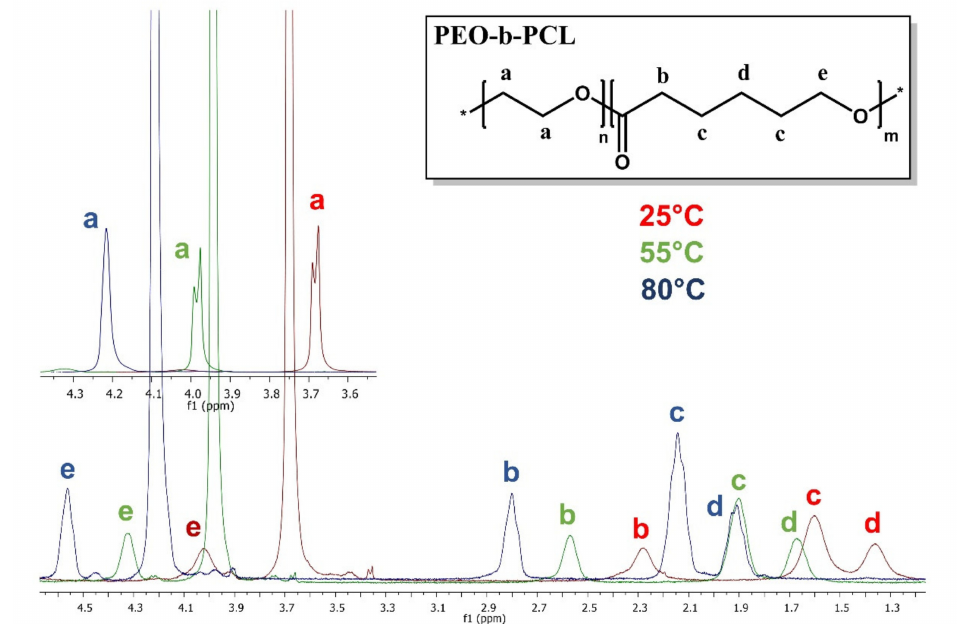
Figure 12. Comparison of 1 H-NMR spectra of -PEO-b-PCL diblock at various temperatures. The red, green, andbluelettersrefertotheprotonsofPEO-b-PCLcopolymerat25 ◦ C,55 ◦ Cand80 ◦ C,respectively. The black letters (a–e) denote the protons of the copolymer structure. Asterisk in the chemical structure of the copolymer denotes the presence of end groups at the ends of the copolymer